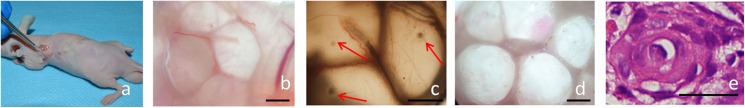
Capsules transplanted in vivo.(a) Capsules were taken out. (b–d) Observed under the microscope, arrows indicate cell spheroids (red). (e) Thirty days after the capsules were transplanted subcutaneously into nude mice, HE sections, and cells formed concentric circles. Scale bars = 1 mm in b, c, and d; 50 μm in e.